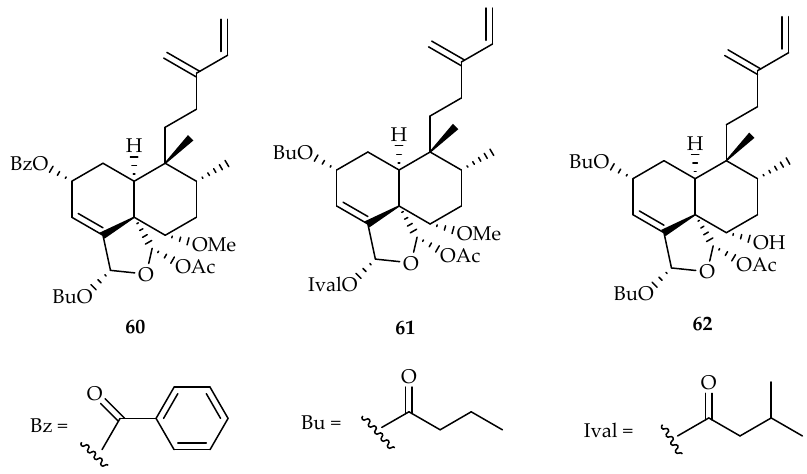
Figure 26. Structures of kurziterpene B 60 , kurziterpene D 61 , and kurziterpene E 62 [41].